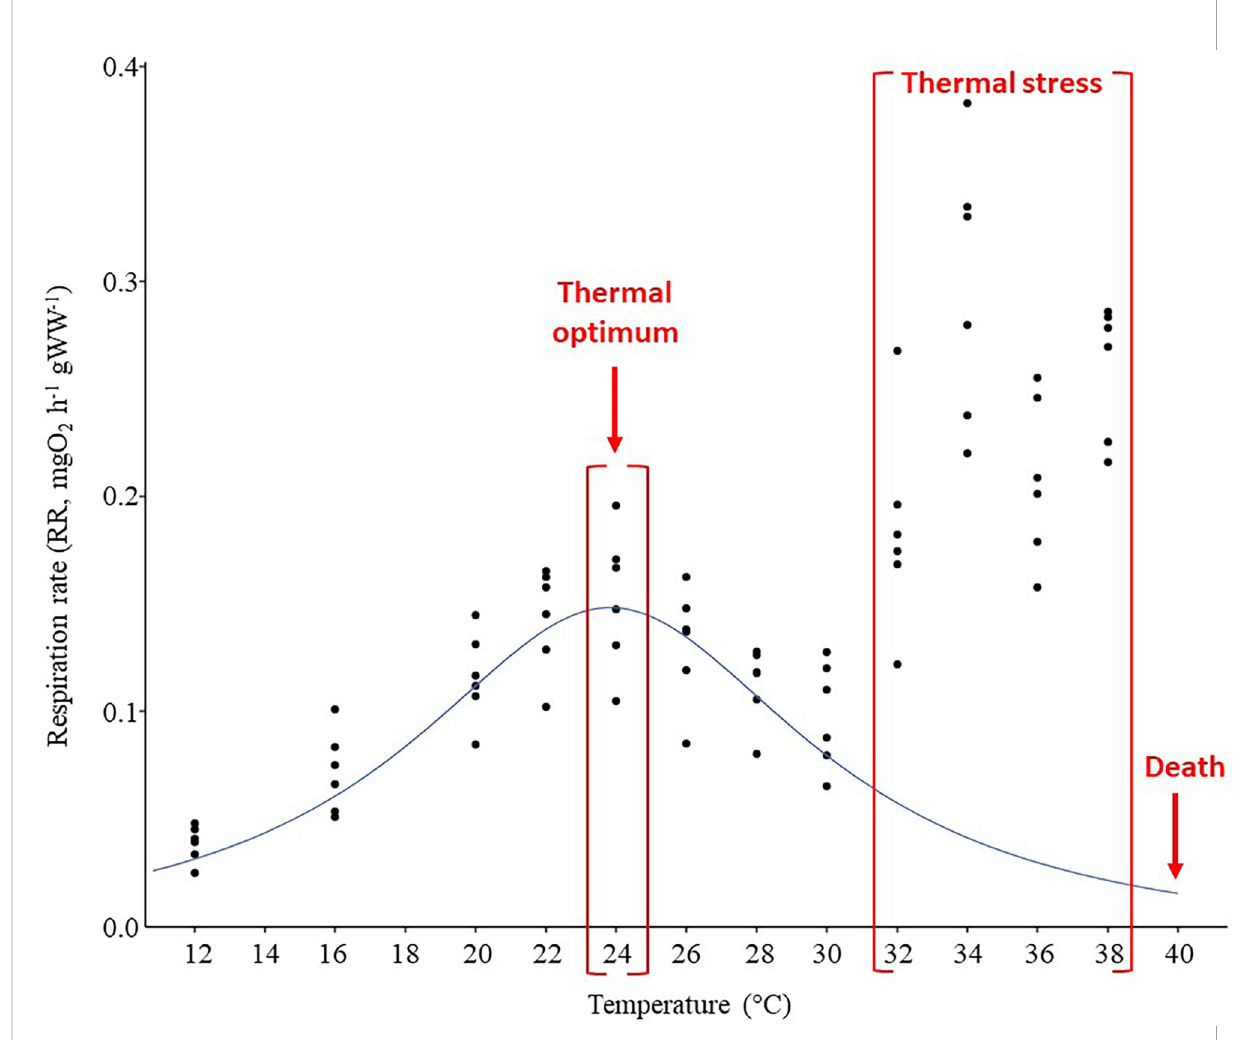
FIGURE 2 Respiration rate (RR; mgO 2 h – 1 gWW – 1 ; WW: wet weight) of Callinectes sapidus as a function of the temperature measured experimentally. The blue line represents the mean thermal performance curve (TPC) regression. The red indications explain the trends and the metabolic responses to the different